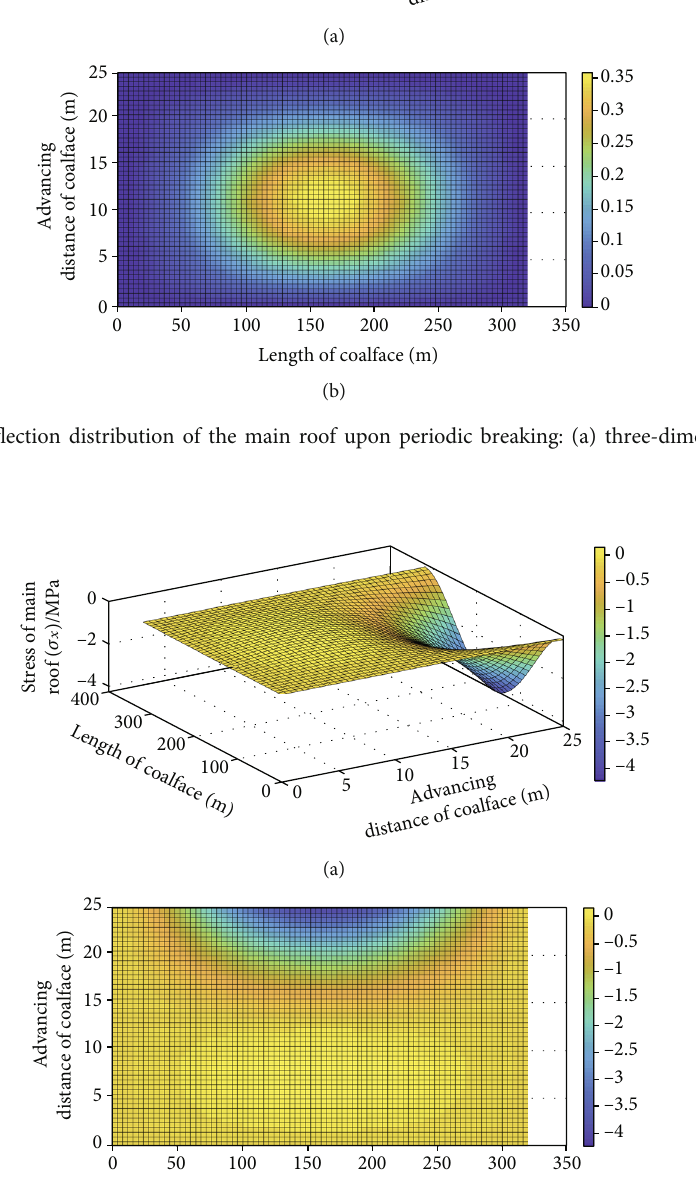
Figure 7: Distribution characteristics of stress σ and (b) planar distribution of stress σ x